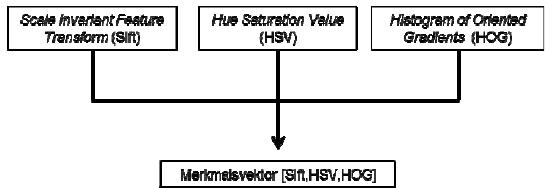
Figure 7: Elements of the feature vector (Merkmalsvektor) (Source: Stitz, 2014).